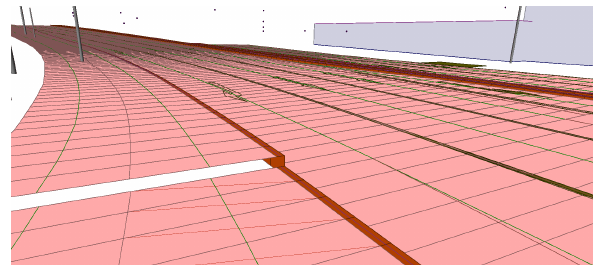
Figure 16. Dataset containing a biking lane gap at a road transition. This only becomes visible in the CityGML representation of the dataset.